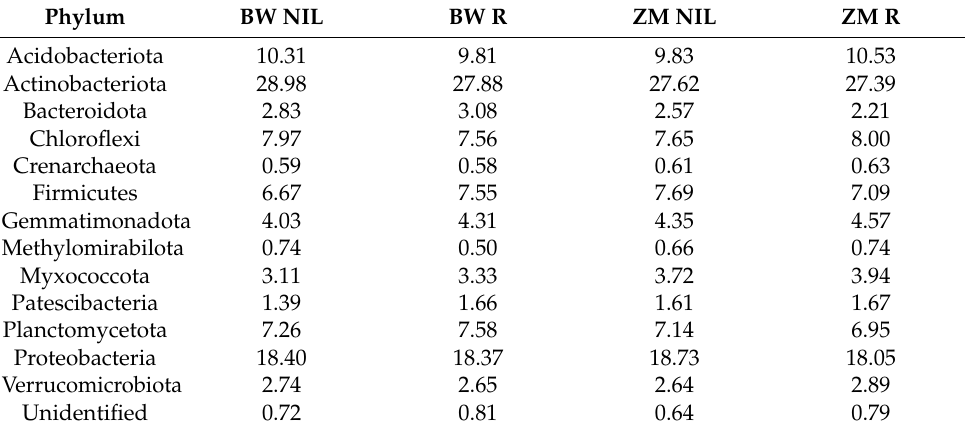
Figure 1. Bacterial community composition in the plant rhizosphere at plant harvest. ( A ) Bar plot showing the average distribution of main phyla (with abundances of >0.5%) in the soils. ( B ) Visualization of a multidimensional scaling approach (PCoA) to explore dissimilarities between the soil communities. The respective three replicates of each color-coded treatment are connected to each other. ZM = maize ( Z. mays ), BW = buckwheat ( F. esculentum ), NIL = reference soil, R = inoculated soil, FGxx = sample ID. Table 1. Mean proportions (given in % of the total community) of main phyla (with abundances of >0.5%) in the soils of the studied treatments. Soils were cultivated with Fagopyrum esculentum /buckwheat (BW) or Zea mays (ZM) without inoculation (NIL) and with inoculation (R) of B. amyloliquefaciens.